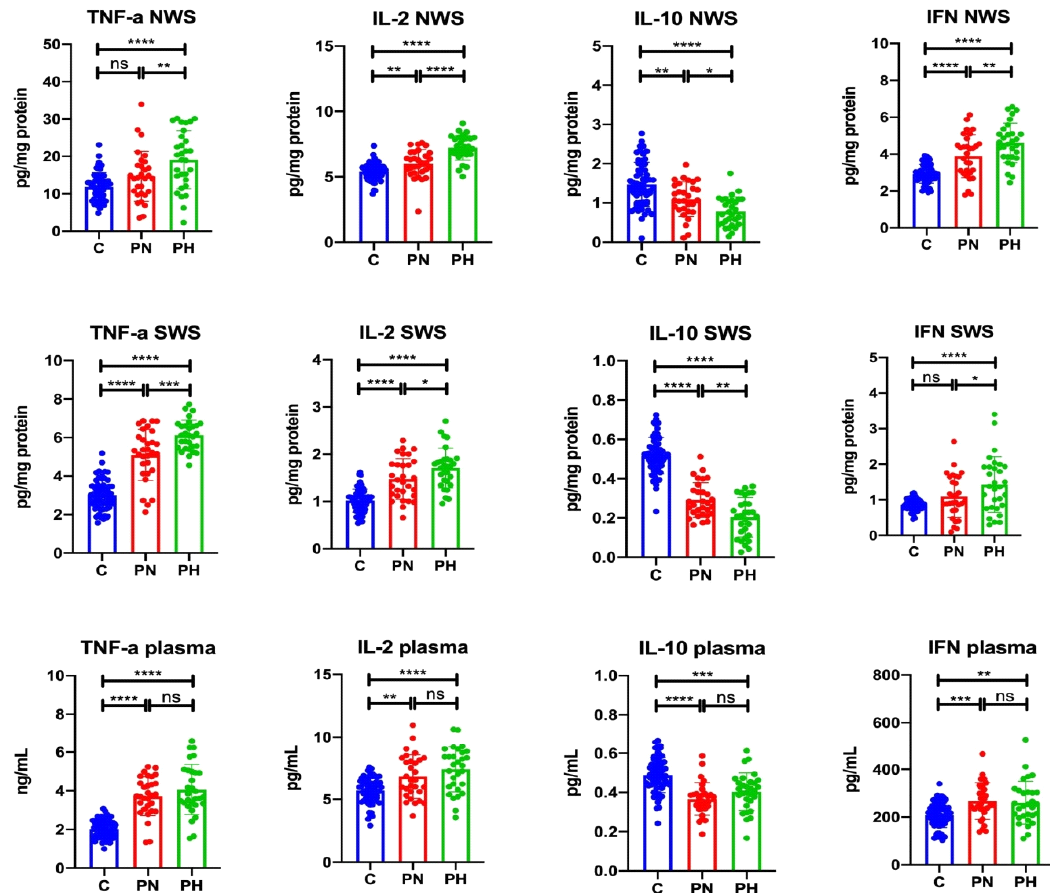
Figure 1. Cytokine levels in unstimulated and stimulated saliva as well as plasma of plaque psoriasis patients with normal salivation and hyposalivation. Abbreviations: C—the control; IL-2—interleukin 2; IL-10—interleukin-10; INF- γ —interferon-gamma; ns—not significant; NWS—non-stimulated whole saliva; PN—psoriasis patients with normal salivation; PH—psoriasis patients with hyposalivation; SWS—stimulated whole saliva; TNF- α —tumor necrosis factor-alpha. * p < 0.05, ** p < 0.01, *** p < 0 . 001, and **** p < 0.0001.